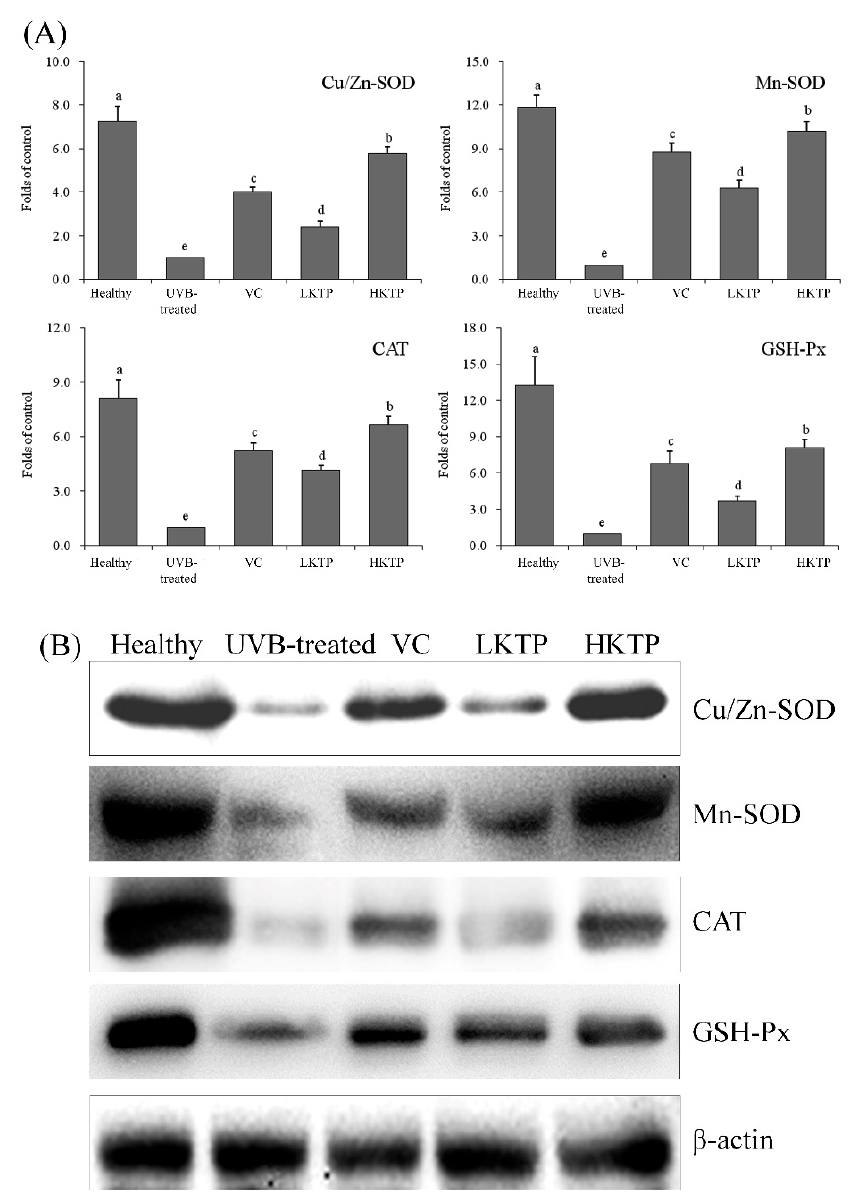
Figure 5. Cu/Zn-SOD, Mn-SOD, CAT, and GSH-Px mRNA ( A ) and protein ( B ) expression in skin tissue of SKH1 hairless mice with UVB-induced skin aging. Values presented are the means ± standard deviation (N = 10/group). a–e Mean values with different letters in the same bars are significantly different ( p < 0.05) according to Duncan’s new MRT. VC: mice were smeared with 5.0% VC solution; LKTP: mice were smeared with 2.5% polyphenols of Kuding tea; and HKTP: mice were smeared with 5.0% polyphenols of Kuding tea.